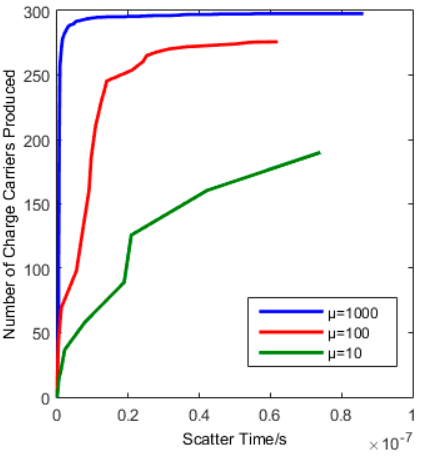
Figure 5. A plot indicating the number of charge carriers versus time showing the effect of changing the II